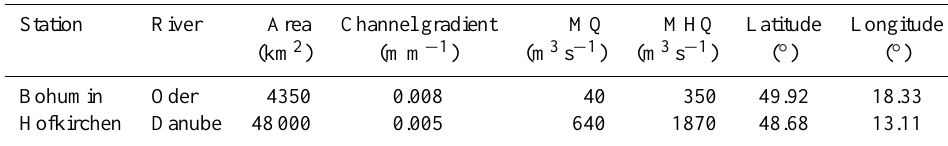
Table 1. River Gauging station information for Bohumin and Hofkirchen including stream-flow characteristic value MQ (mean discharge) and MHQ (average yearly mean